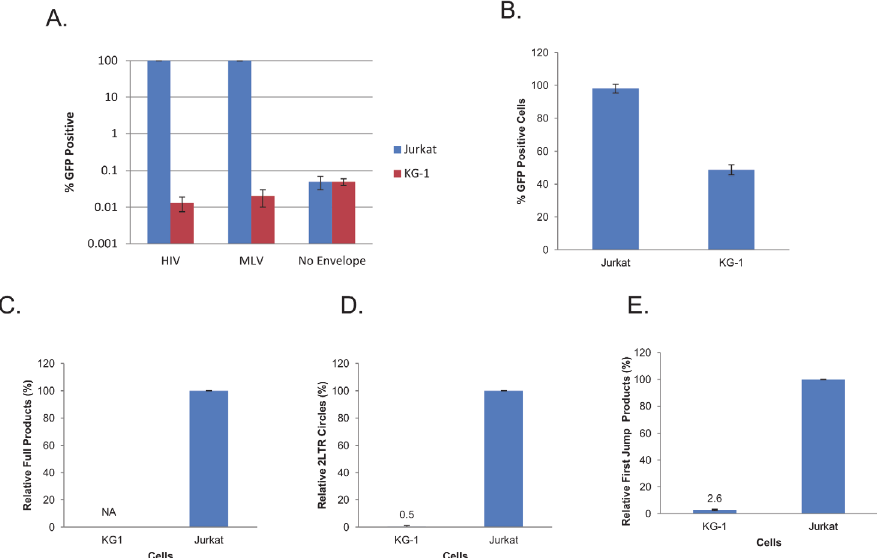
Fig 2. KG-1 cells cannot be infected with VSVG pseudotyped retroviruses. (A) KG-1 and Jurkat cells were infected with HIV-VSVG, MLV-VSVG (at an MOI of 10) or with an envelope deficient HIV with p24 levels that were equivalent to HIV-VSVG. Percent of GFP positive cells were determined using flow cytometry 3 days post infection. ( B) KG-1 and Jurkat cells were infected with Measles virus encoding GFP at an MOI of 3. Percent of GFP positive cells were determined using flow cytometry 48 hours post infection. (C) KG-1 and Jurkat cells were infected with HIV-VSVG at an MOI of 1 and viral cDNA products were quantified using qPCR for integrated provirus at 6 weeks post infection; NA — no amplification (D) for 2LTR circles at 48 hours post infection and (E) for first jump products 8 hours post infection. Error bars are calculated as standard deviations of the mean of at least three independent